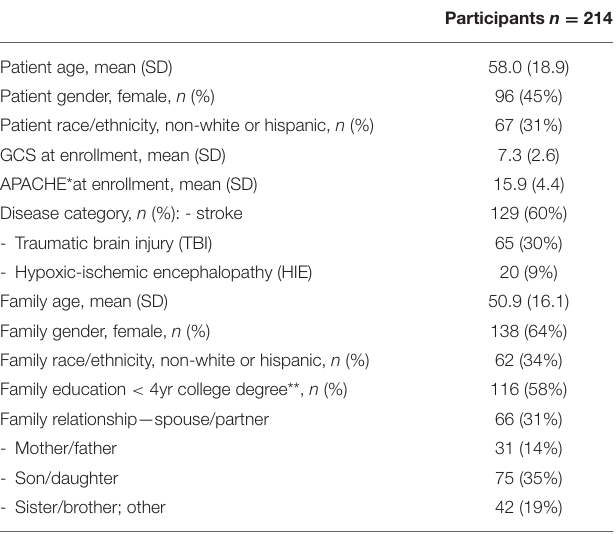
TABLE 1 | Patient and Family characteristics.